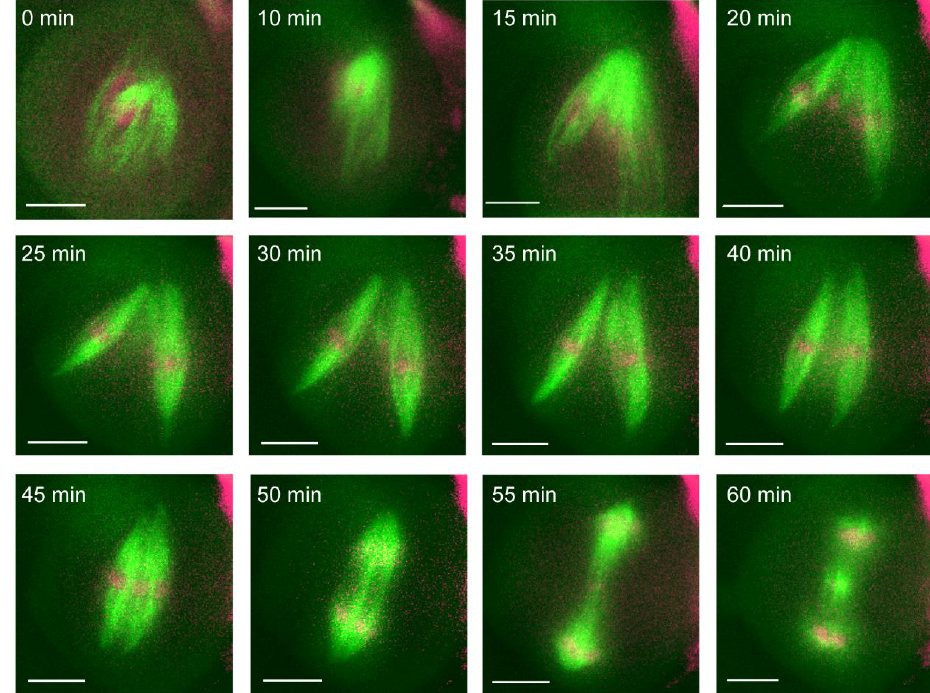
Figure 7. In vivo correction merging two bipolar spindles. Two bipolar spindles (green) were assembled in a single meiosis I cell (0–35 min). This error was corrected before anaphase (50 min) by merging the two spindles into a single spindle (35–45 min). After correction, the spindle successfully separated chromosomes (magenta) (50–60 min). Scale bars: 10 µm.